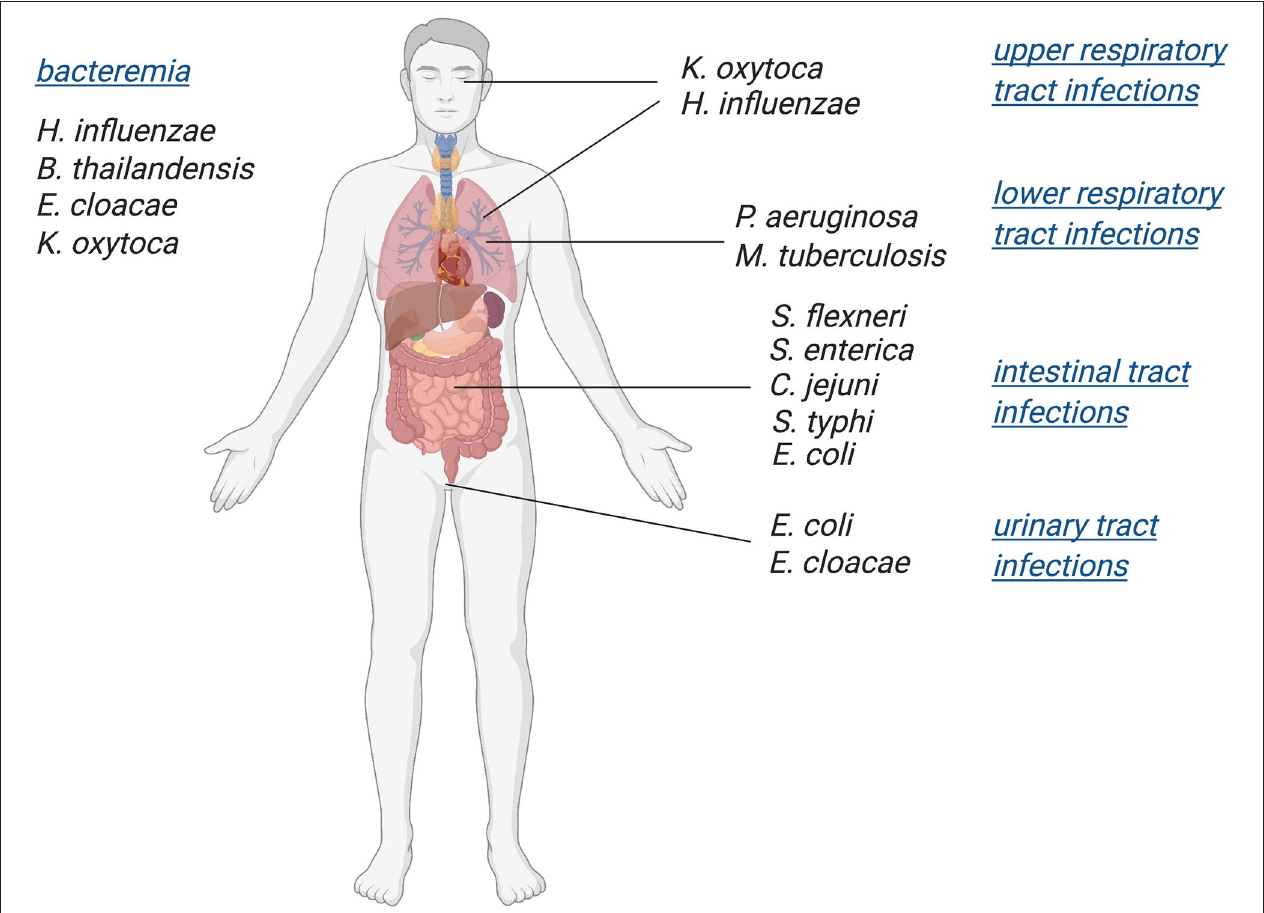
FIGURE 1 | Schematic overview of bacterial pathogens in which Mo-enzymes have been shown to support virulence. Infections with these pathogens affect a variety of body niches, as well as systemic